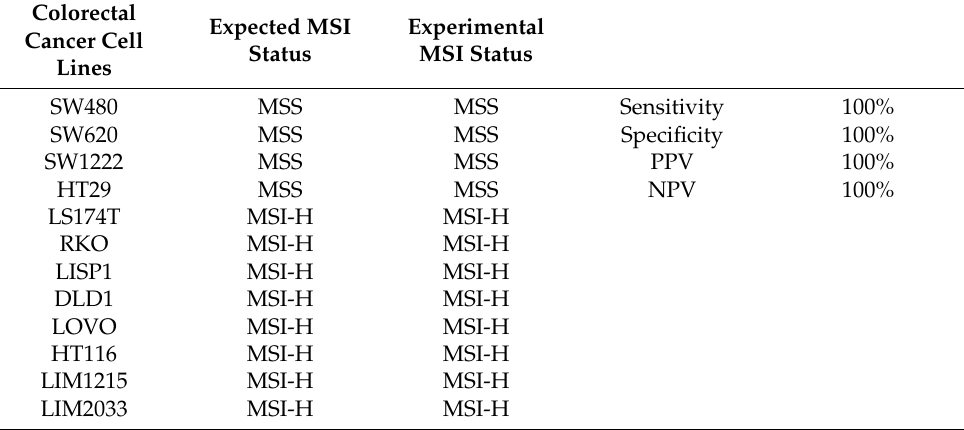
Table 3. Sensitivity, specificity, positive and negative predictive value of high-resolution capil- lary electrophoresis of colorectal cancer cell lines by visual inspection of high-resolution capillary electrophoresis